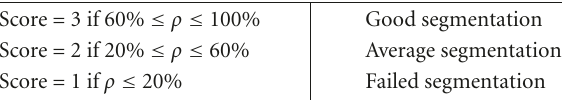
Table 1: Ranking options for evaluation of segmentation